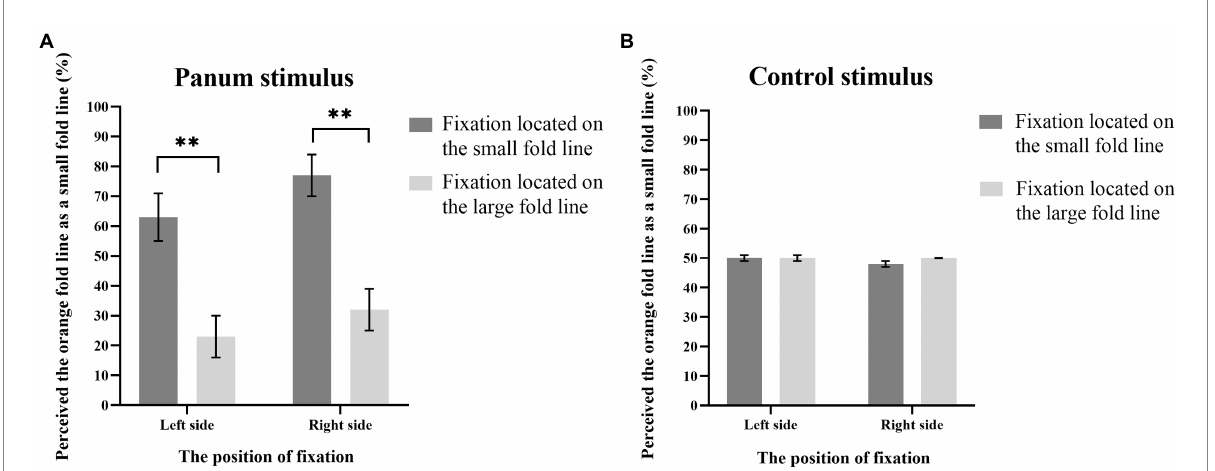
FIGURE 7 Results of Experiment 2. The y-axis indicates the probability that participants perceive the orange fold line as a small fold line under various experimental conditions, and the x-axis noted that the position of fixation. The error bars in the figures refer to standard error. The symbol “**” represents a p -value of <